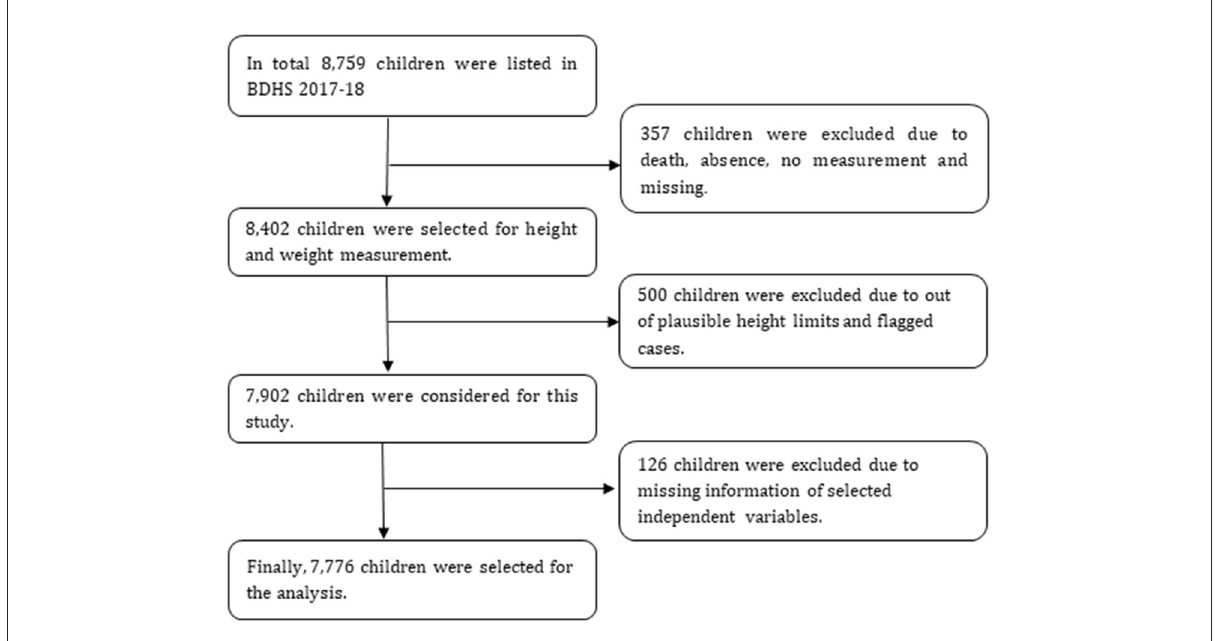
FIGURE1 Schematic presentation of sample size